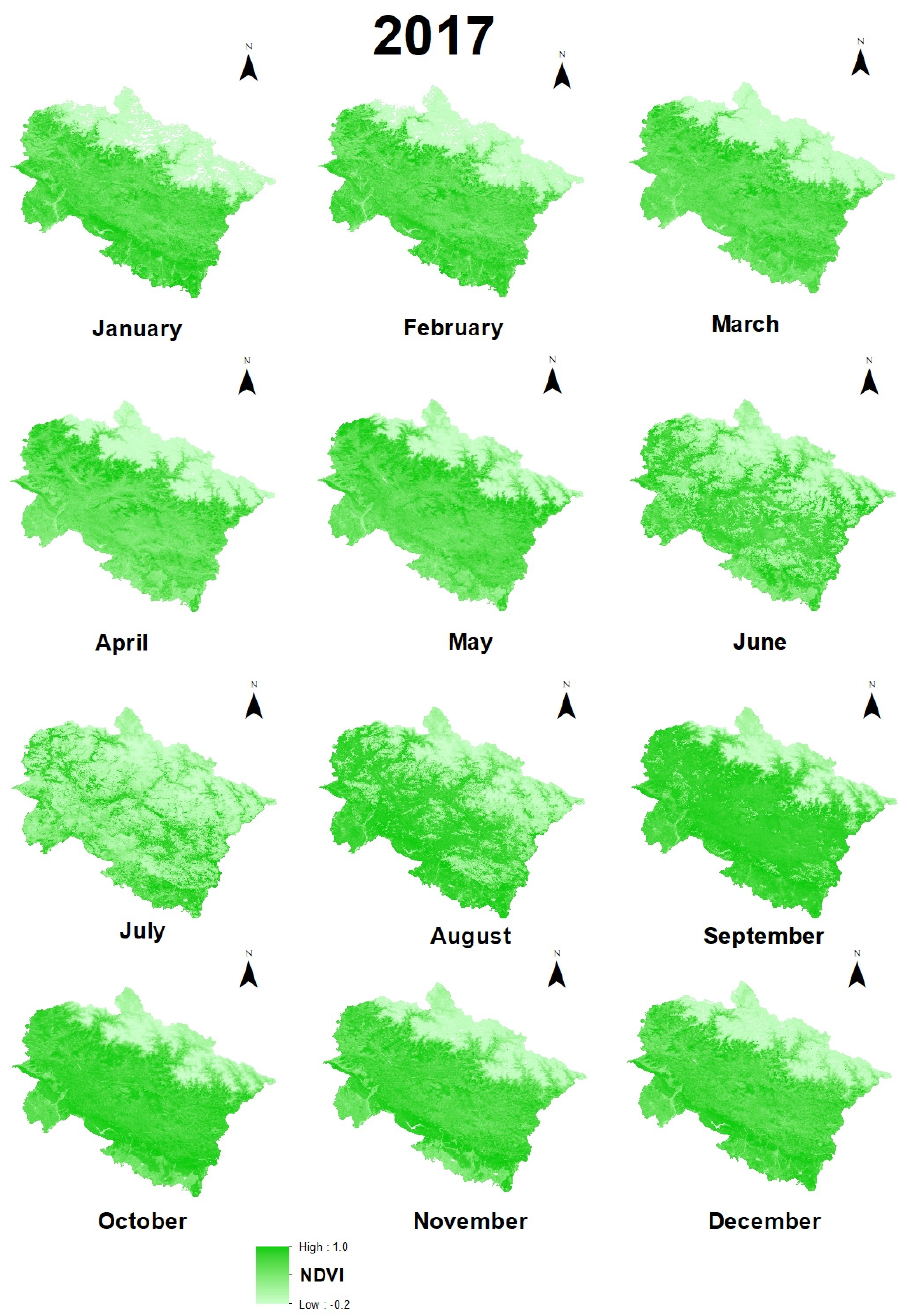
Figure 4. Monthly fluctuations of vegetation cover in Uttarakhand in 2017.